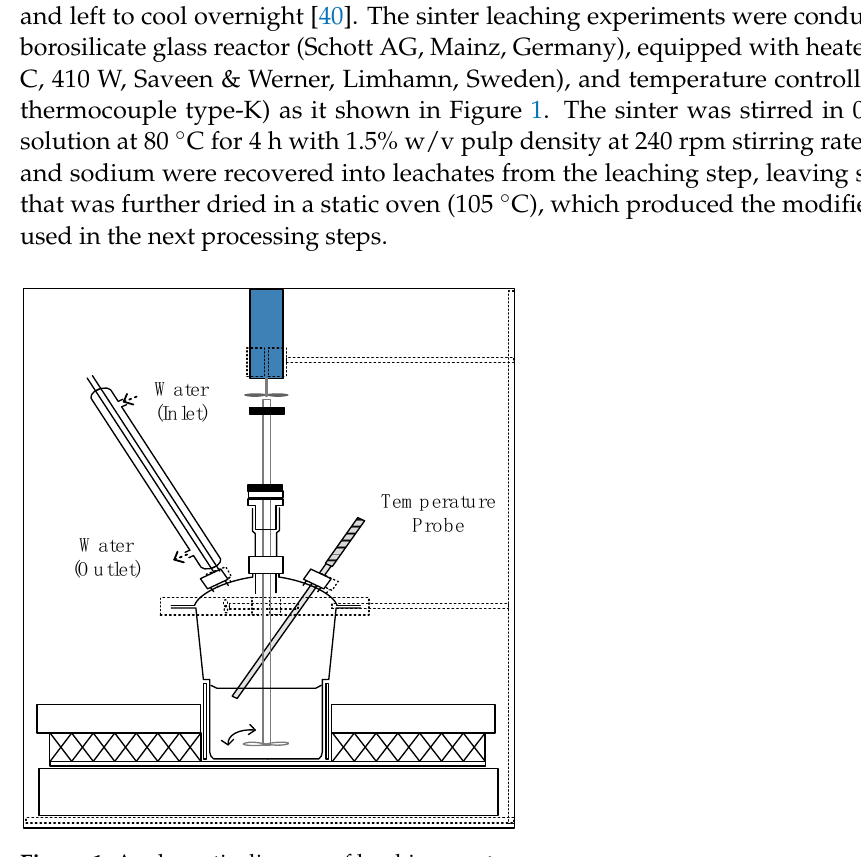
Figure 1. A schematic diagram of leaching reactor.